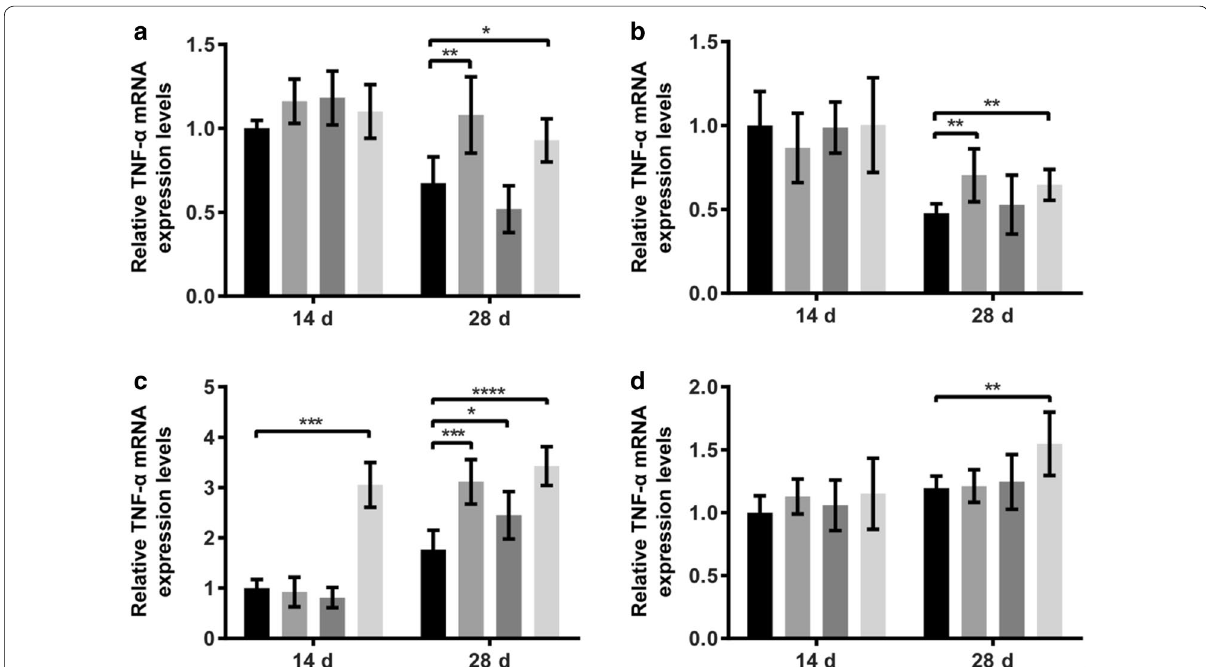
Fig. 2 Effects of different dietary supplements on the relative mRNA expression of TNF‑α of laying hens. a Expression levels of TNF‑α mRNA in the liver at different time points; b Expression levels of TNF‑α mRNA in the spleen at different time points; c Expression levels of TNF‑α mRNA in the